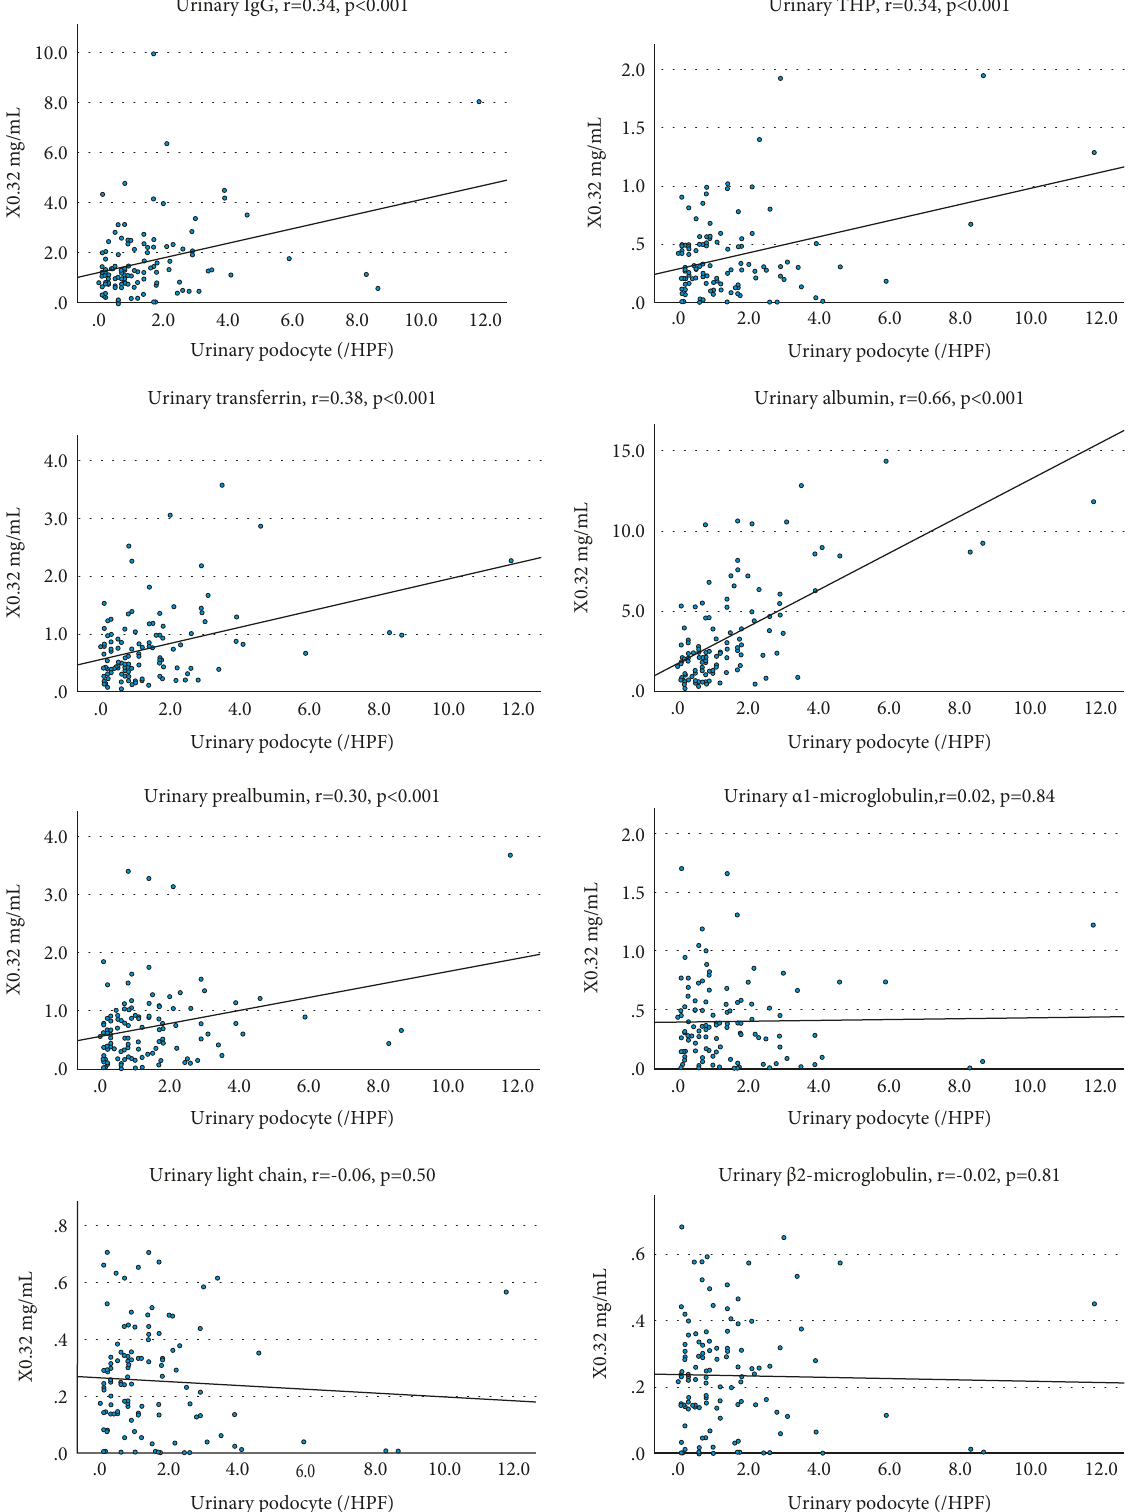
Urinary podocyte (/HPF)